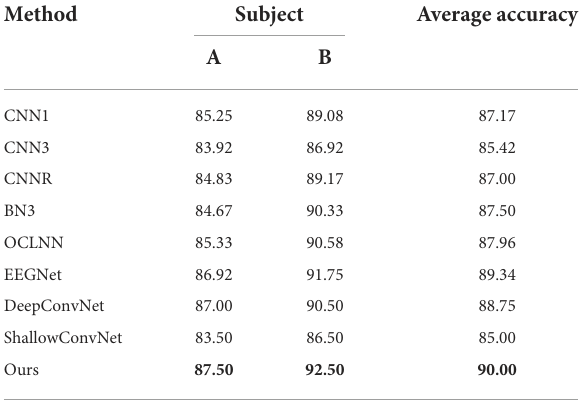
TABLE 6 Classification accuracy ( % ) on BCI competition III dataset.